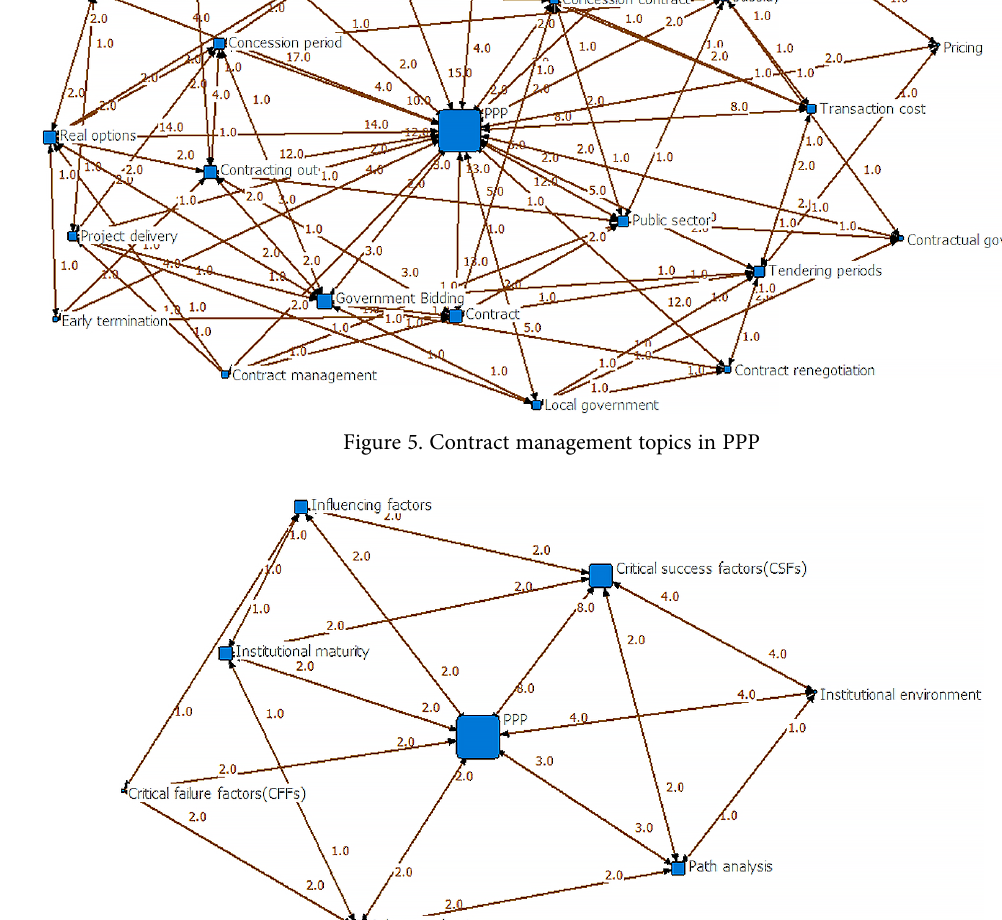
Figure 6. CSFs and CFFs topics in